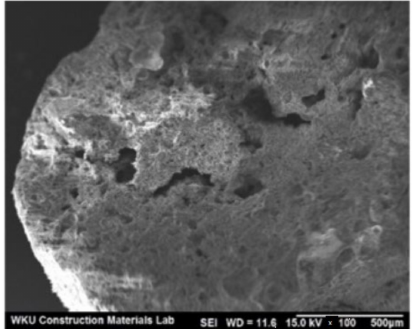
Figure 2. SEM of artificial lightweight aggregate made up of calcining coal ash and dredged soil